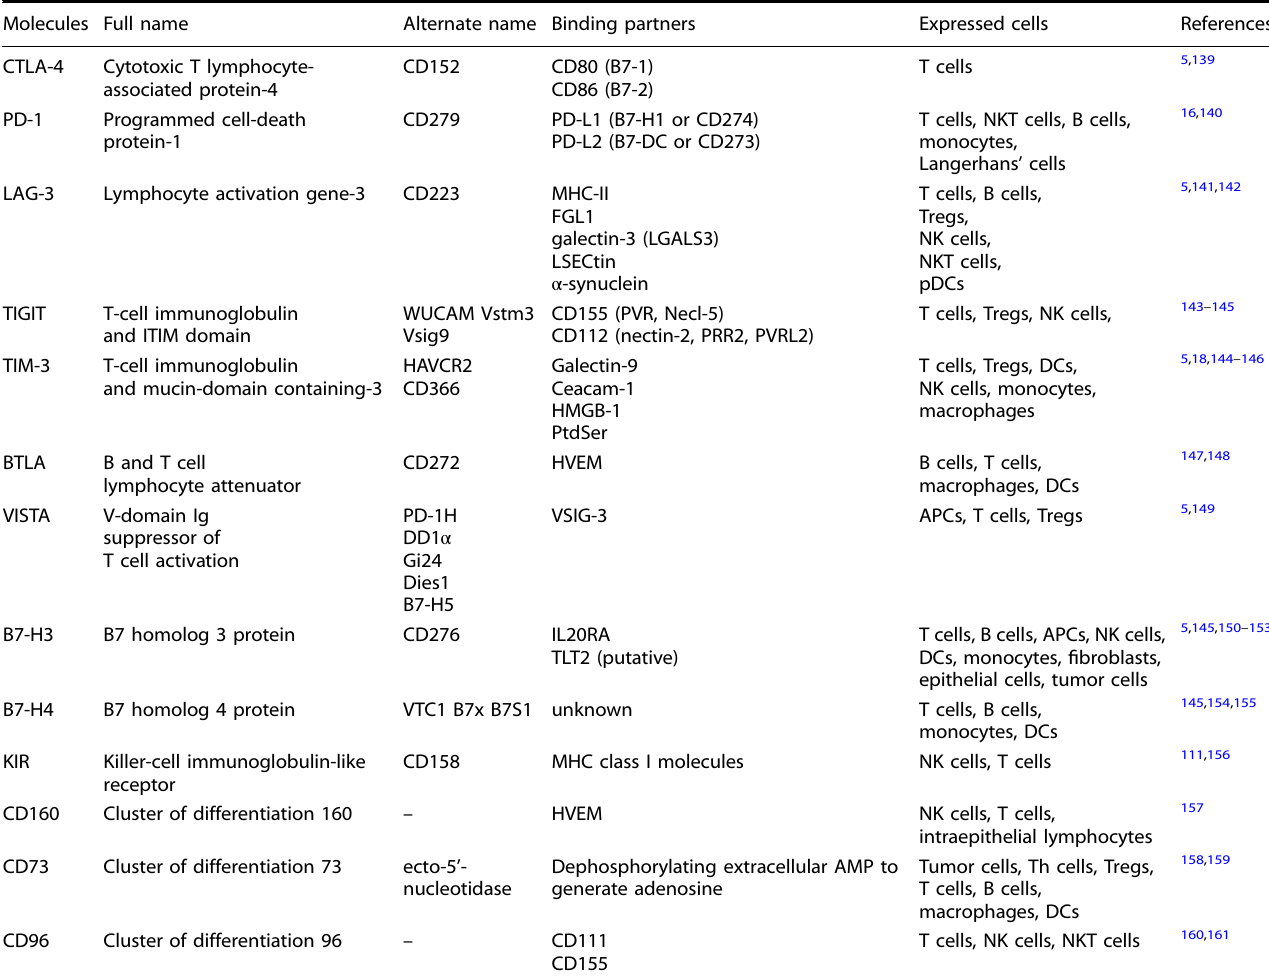
Table 1. A summary of immune checkpoint molecules Molecules Full